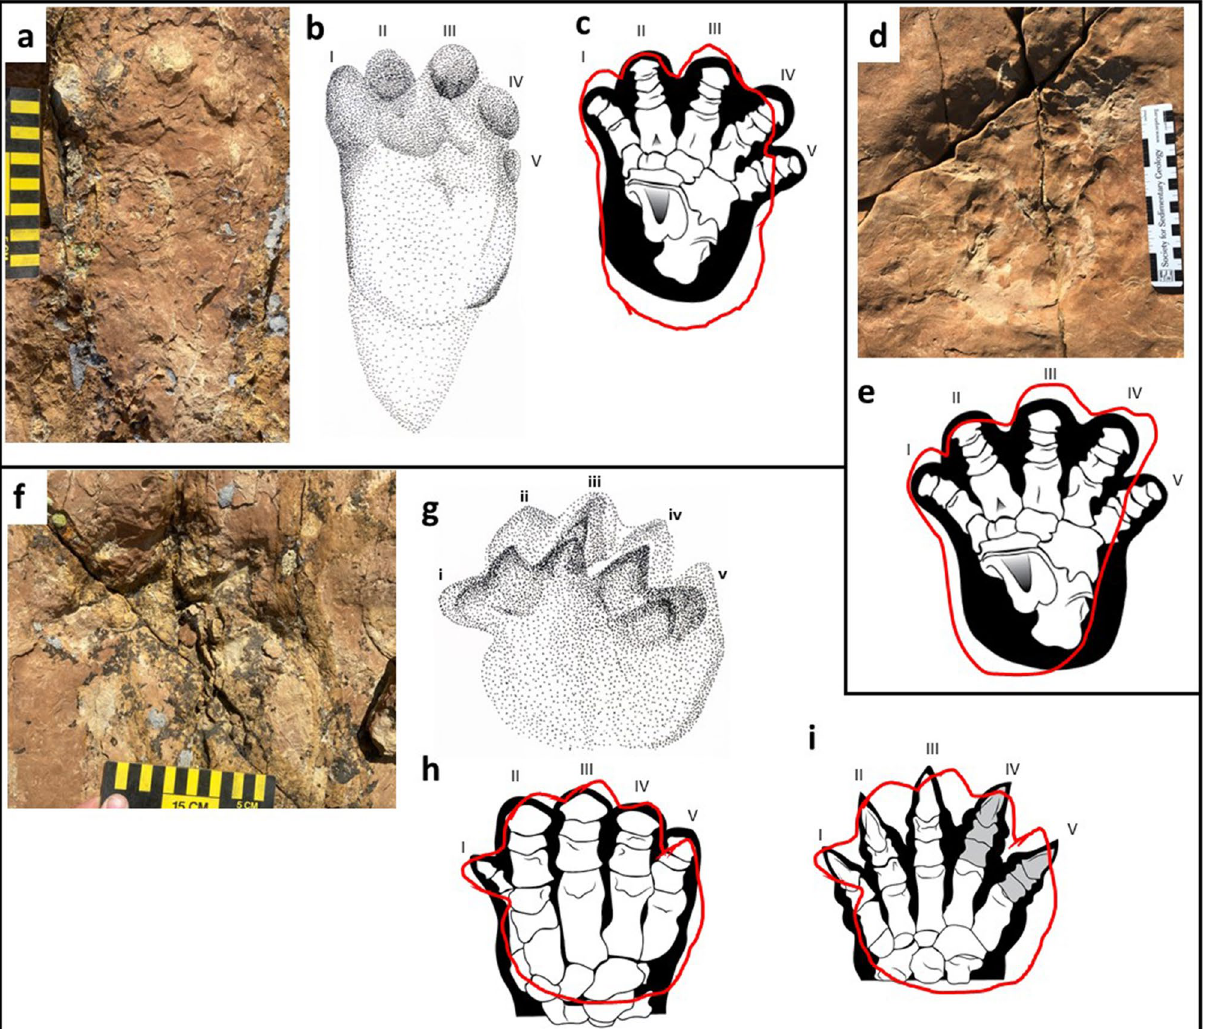
Figure 5. Representative examples of individual five-toed footprints with clear toe impressions. Scale bars are 15 cm. ( a ) Photograph of five-toed pes; ( b ) Interpretive sketch of a with digits numbered; ( c ) Illustration of skeletal elements of Coryphodon radians pes (modified from original 18 ) with outline of a superimposed; ( d ) Photograph of five-toed pes demonstrating deep penetration; ( e ) Illustration of skeletal elements of C. radians pes (modified from original 18 ) with outline of d superimposed; ( f ) Photograph of five-toed print identified as a manus or possible direct register pes imprint; ( g ) Interpretive sketch of f with digits numbered; ( h ) Illustration of skeletal elements of C. radians manus (drawn from mounted specimen) with outline of f superimposed; ( i ) Illustration of skeletal elements of Titanoides primaevus manus with missing bones in grey (modified from original 19 ) with outline of f superimposed. Drawings made by A F-J W in Adobe Illustrator 2021 (version 25.2.1, https:// www. adobe. com/ produ cts/ illus trator. html). Photographs by A F-J W and compiled in Microsoft PowerPoint (version 16.0.13801.20266, https:// www. micro soft. com/ en- us/ micro soft- 365/ power